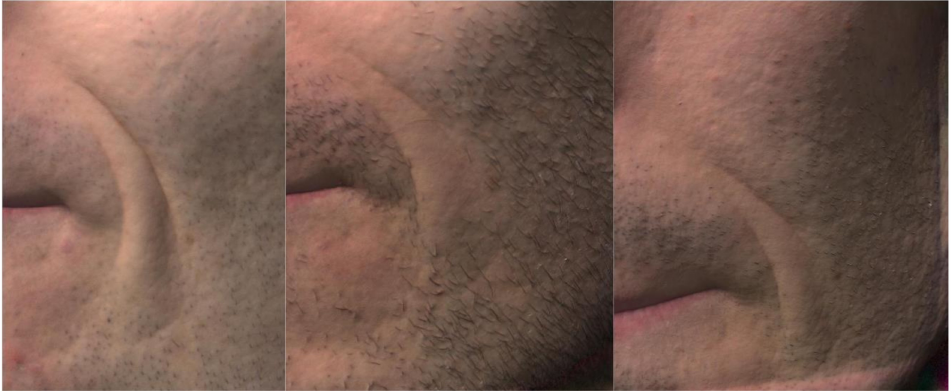
Figure 10. Comparison of preoperative and postoperative photography based on the nasolabial fold (patient no. 6); Left : NLF preoperative (WW 2); middle : NLF after injection of 1,5 cc after 6 weeks (WWS 1); right : NLF after 12 months (WWS